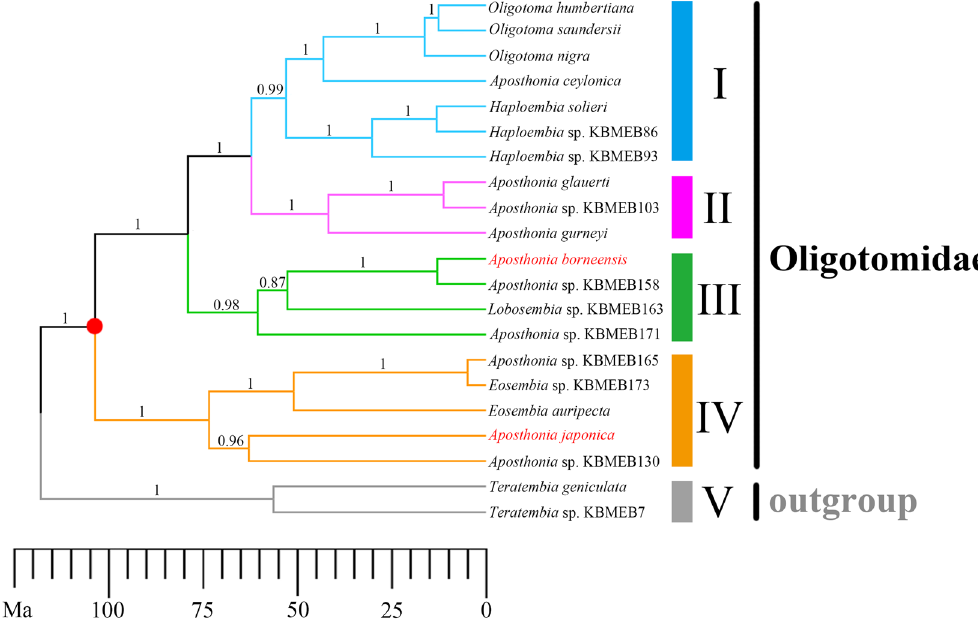
Figure 7. Dated Bayesian tree of Oligotomidae. Numbers on branches are Bayesian posterior probabilities. The tree was rooted with two outgroups, T. geniculata and Teratembia sp. KBMEB7.